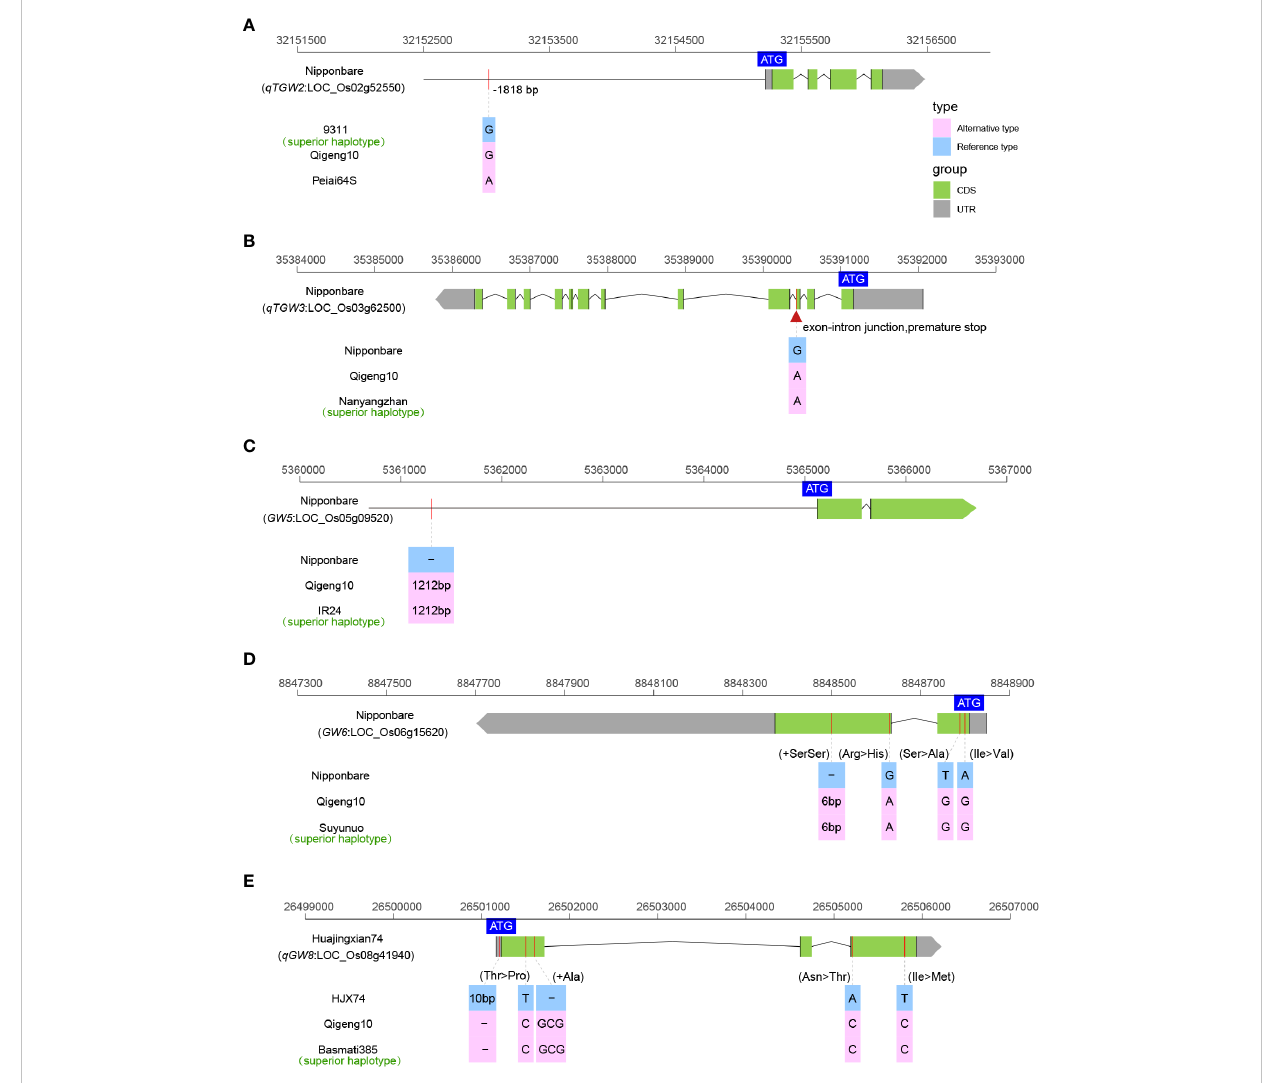
FIGURE 3 The allelic information of sequence variants in qTGW2 (A) , qTGW3 (B) , GW5 (C) , GW6 (D) , and qGW8 (E) controlling grain